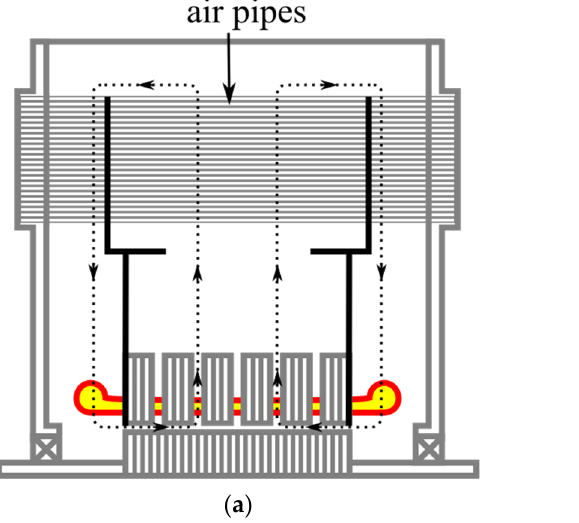
Figure 26. External heat exchanger [126].